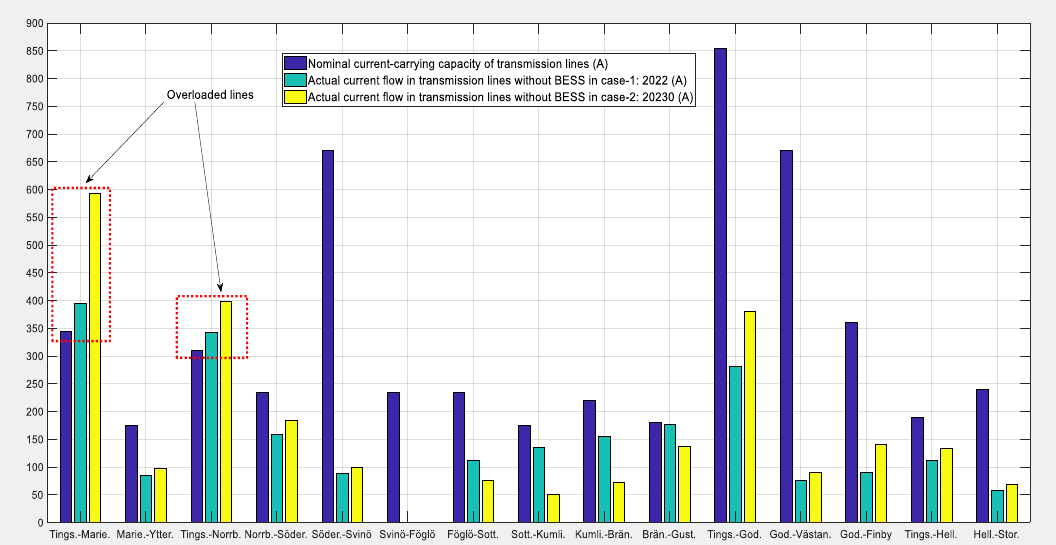
Figure 10. Nominal and actual current flow in transmission lines in the base case study.